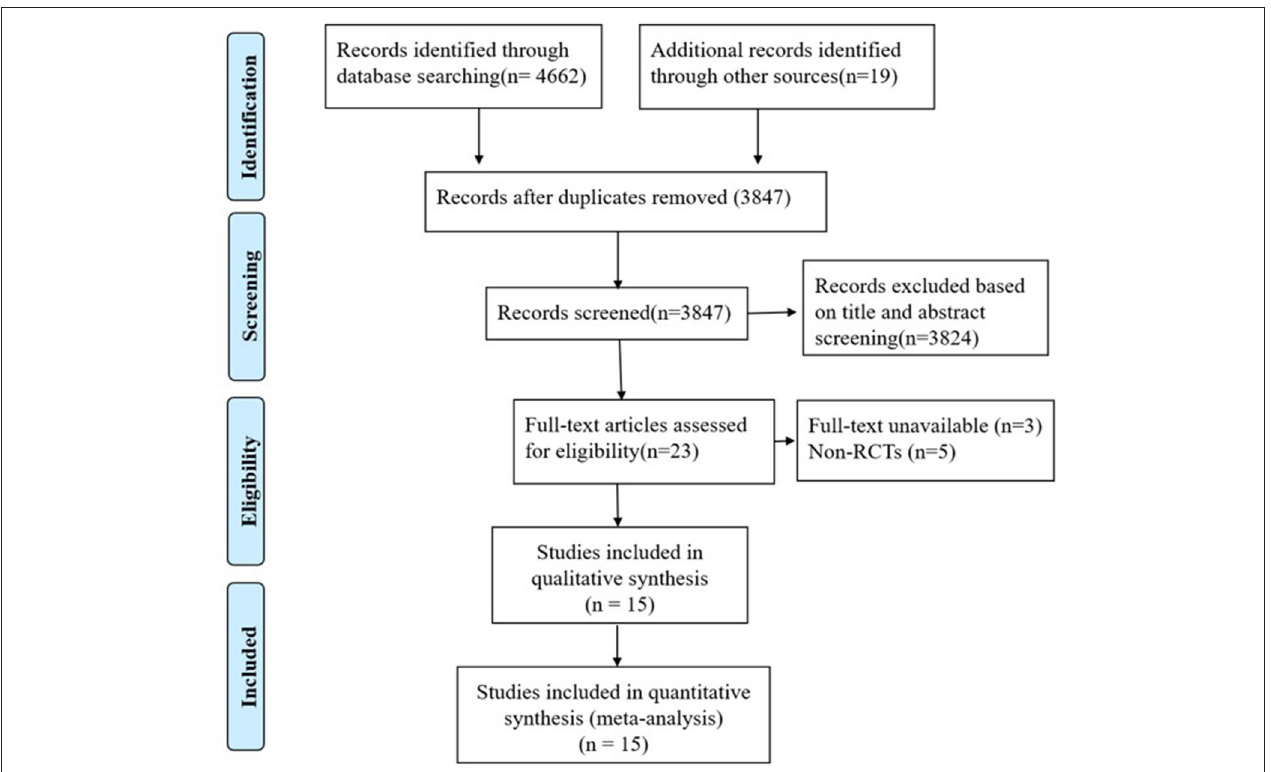
FIGURE 1 | Flowchart of study